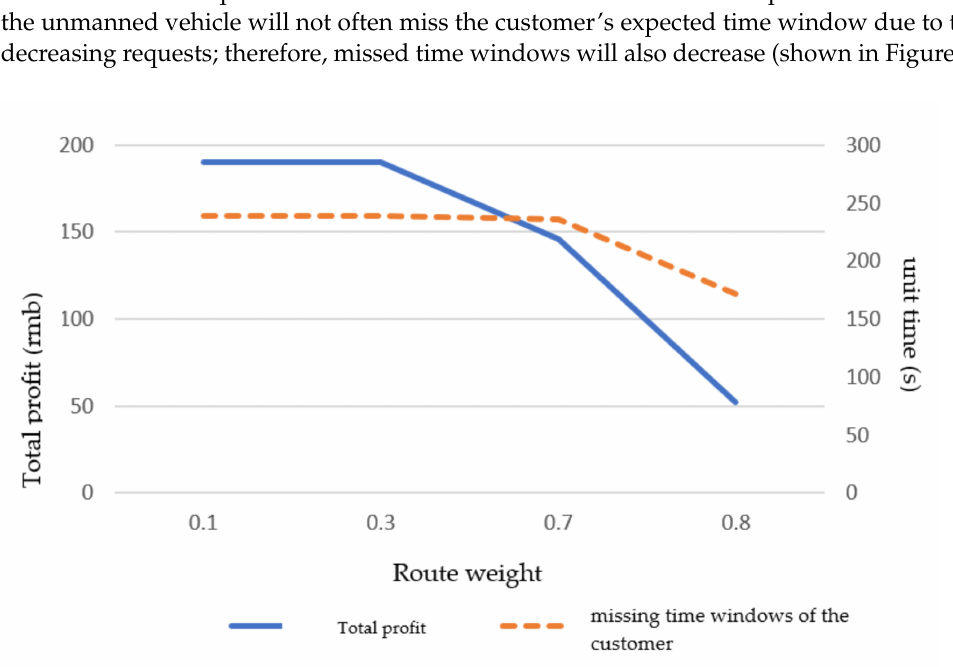
Figure 6. The result of correlations between the shortest route weight, the profit, and missed time